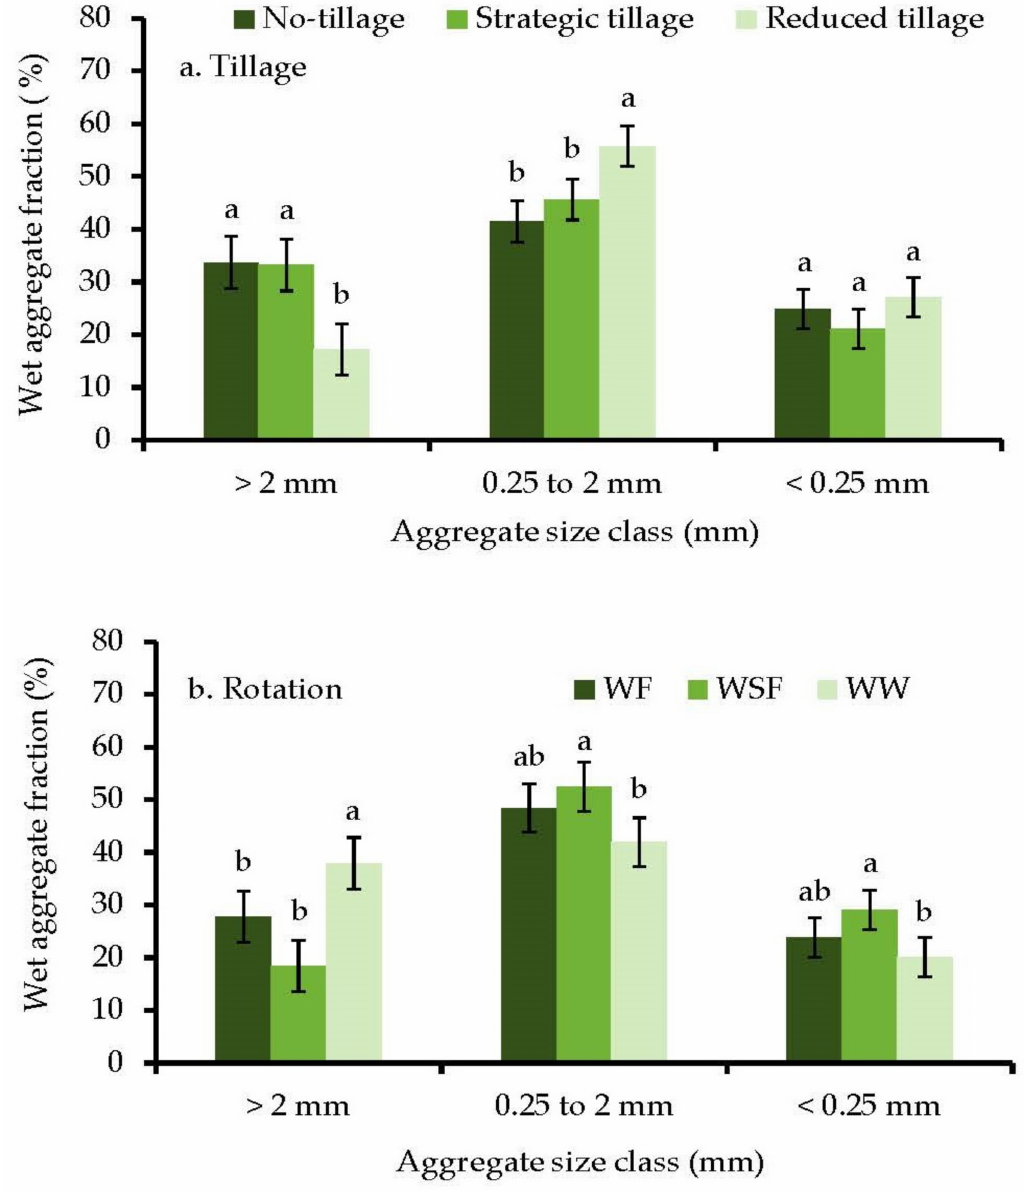
Figure 3. Soil aggregate size distribution as affected by ( a ) tillage and ( b ) crop rotation. Means followed by the same lower-case letter(s) within aggregate size classes are not significantly different using the least squares means (LSMEANS) and adjusted Tukey multiple comparison procedure ( p > 0.05). WF = Wheat-fallow; WSF = wheat-sorghum-fallow; WW =